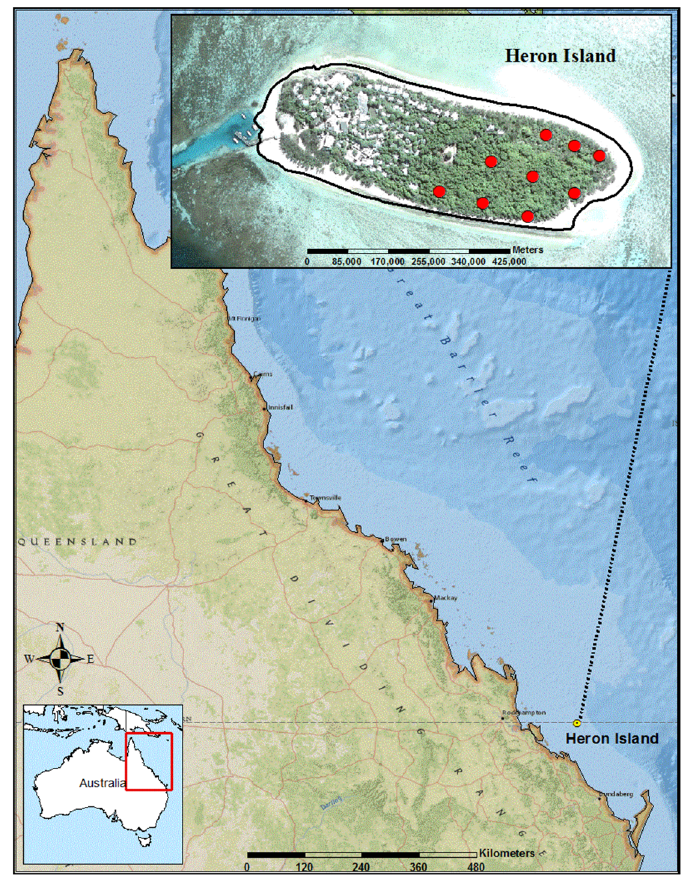
Figure 1. Heron Island study area (inset) in the context of the northeast Australia. Nine lichen monitoring plots (red dots) were selected using a systematic grid overlaid on the Capricornia Cays National Park (eastern) part of the island. The black line surrounding the vegetated portion represents the approximate mean sea level boundary. The Pisonia grandis dominated interior section of the forest appears as a denser, slightly lighter green, cover in contrast to the grey-green fringe Casuarina equisetifolia / Argusia argentea type. Base map of Heron Island from © Google 2015 (Imagery date: 2 August